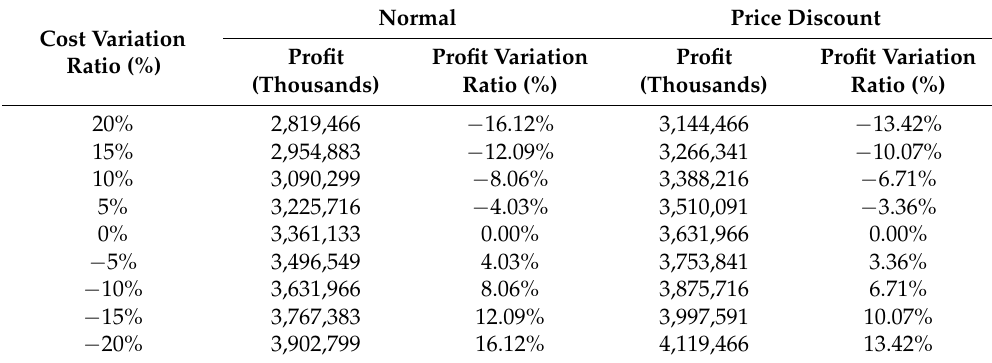
Table 5. Sensitivity analysis on the material